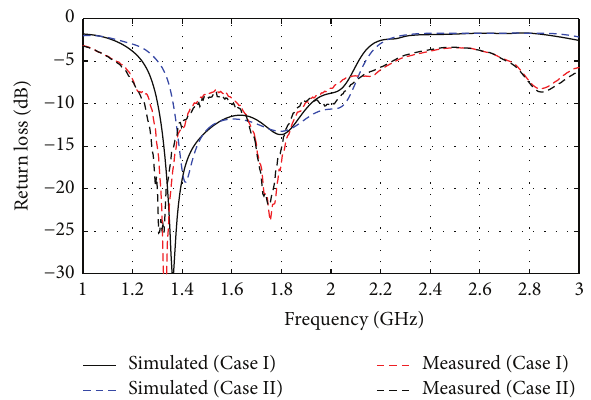
= 10 , 𝐿 = 31 mm, 𝑊 = 5 mm, 𝐿 = 𝑟 1 1 2 = 22 mm, 𝑀 = 33 mm, 𝑠 = 1.575 mm, 1 2 th = 𝑃 = 2 mm, and 𝑊 = 130 mm. 𝑊 𝑙 Figure 13: Comparison between measured and simulated antenna return loss with 𝑎 = 32 mm, 𝑏 = 29.5 mm, 𝑑 = 48.85 mm, 𝜀 𝑟 = 10 , = 31 mm, 𝑊 = 5 mm, 𝐿 = 21 mm, 𝑊 = 1.5 mm, 𝑀 = 𝐿 1 1 2 2 1 = 33 mm, 𝑠 = 1.575 mm, 𝑉 = 0.6 mm, 𝑃 = 𝑃 = 22 mm, 𝑀 2 𝑊 𝑙 th rad 2 mm, 𝐿 = 130mm and 𝑊 = 130 mm.